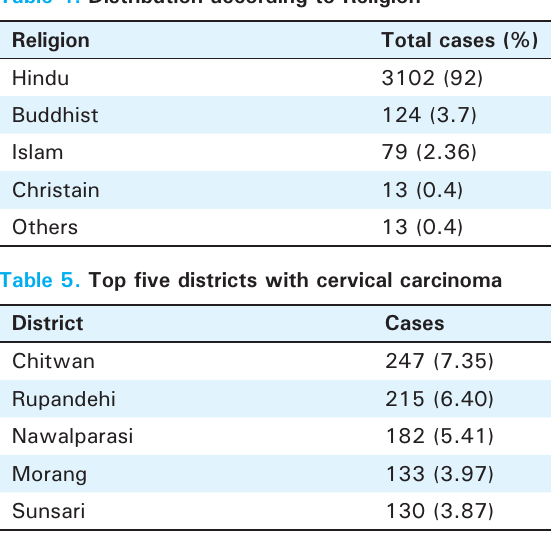
Table 4. Distribution according to Religion